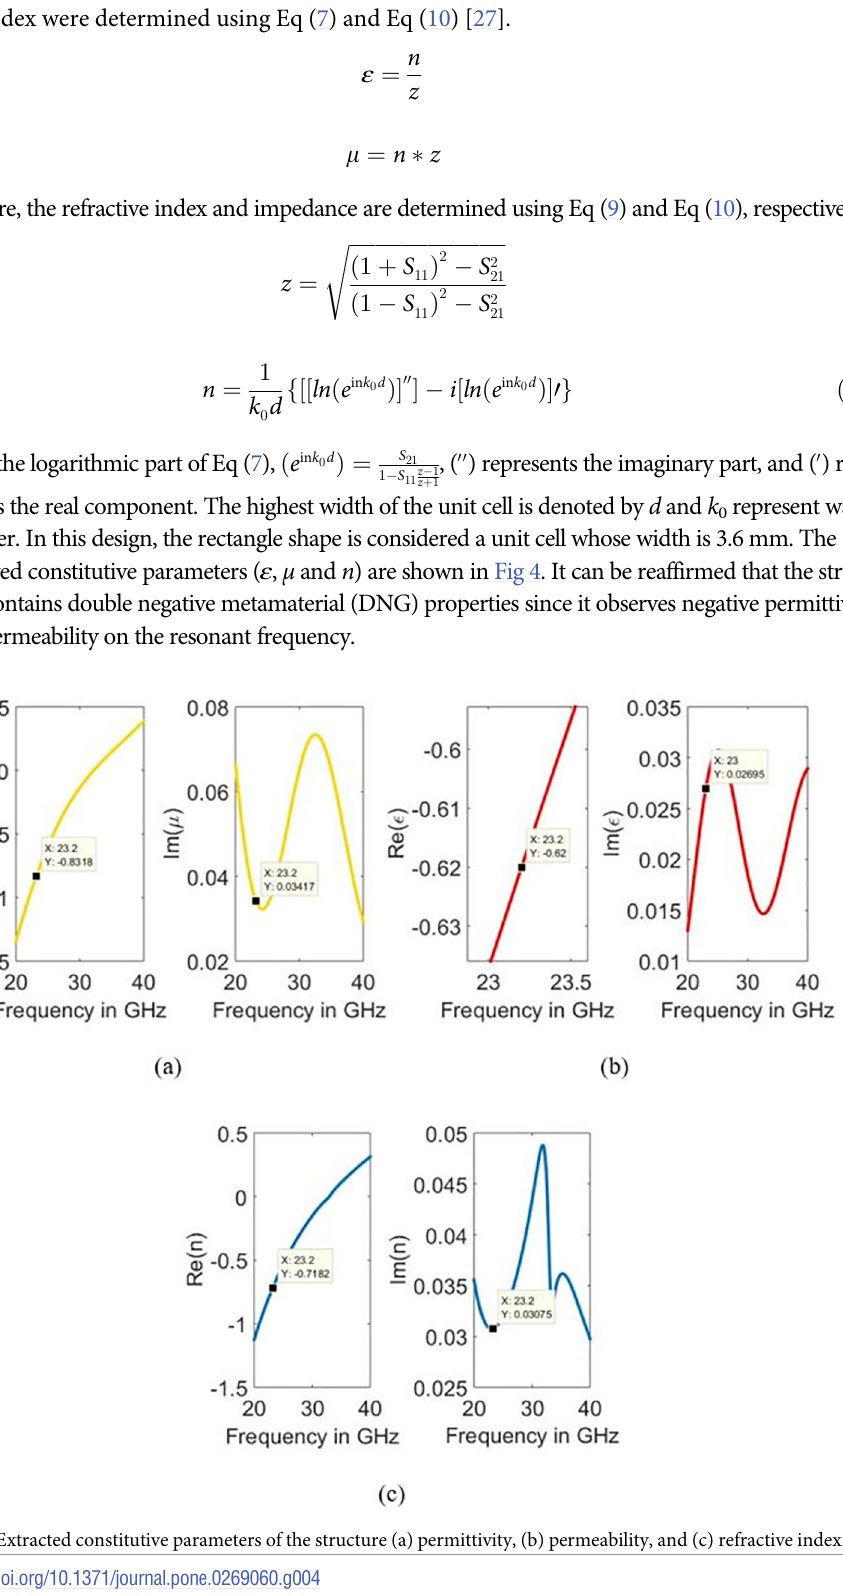
PLOS ONE | https://doi.org/10.1371/journal.pone.0269060 June 29,